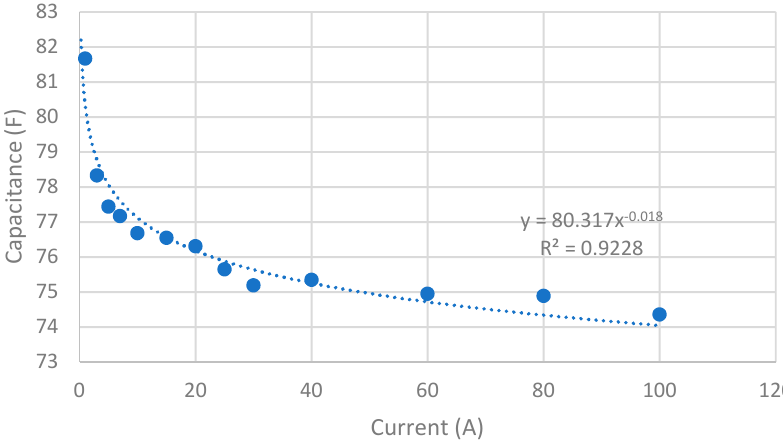
Figure 2. Calculated SC module capacitance as a function of charging current.